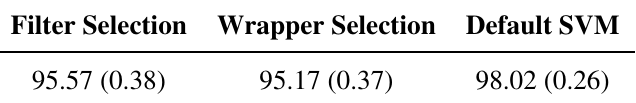
Table 8. Accuracy of a SVM classifier with variable